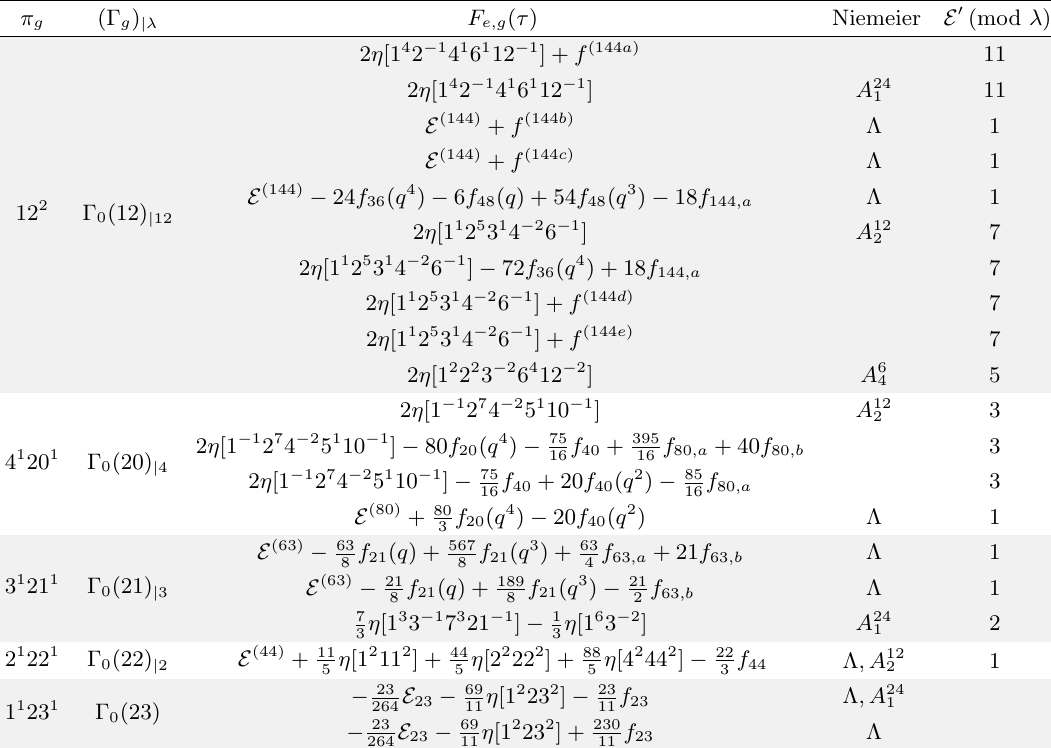
Table 4. Result of formally applying our method for obtaining potential twining genera to Umbral symmetries that do not (cid:12)x a